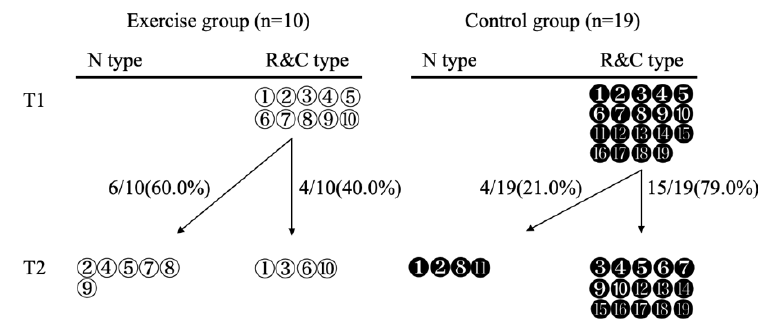
Figure 11. Changes in chewing patterns between T1 and T2.